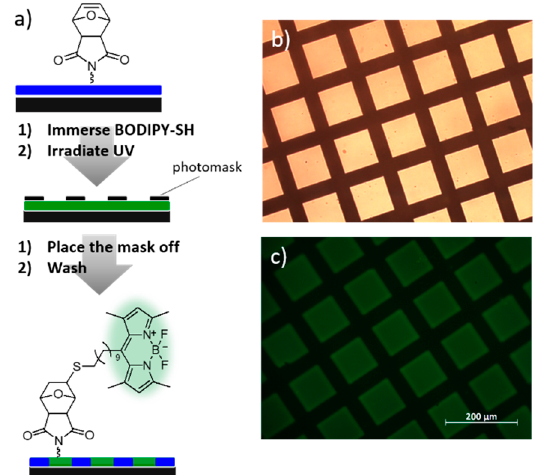
Figure 5. ( a ) Schematic illustration of patterned immobilization via thiol-ene reaction. ( b ) Optical microscopy image of the photo-mask used, and ( c ) fluorescence microscope image of BODIPY patterns on hydrogel H1.